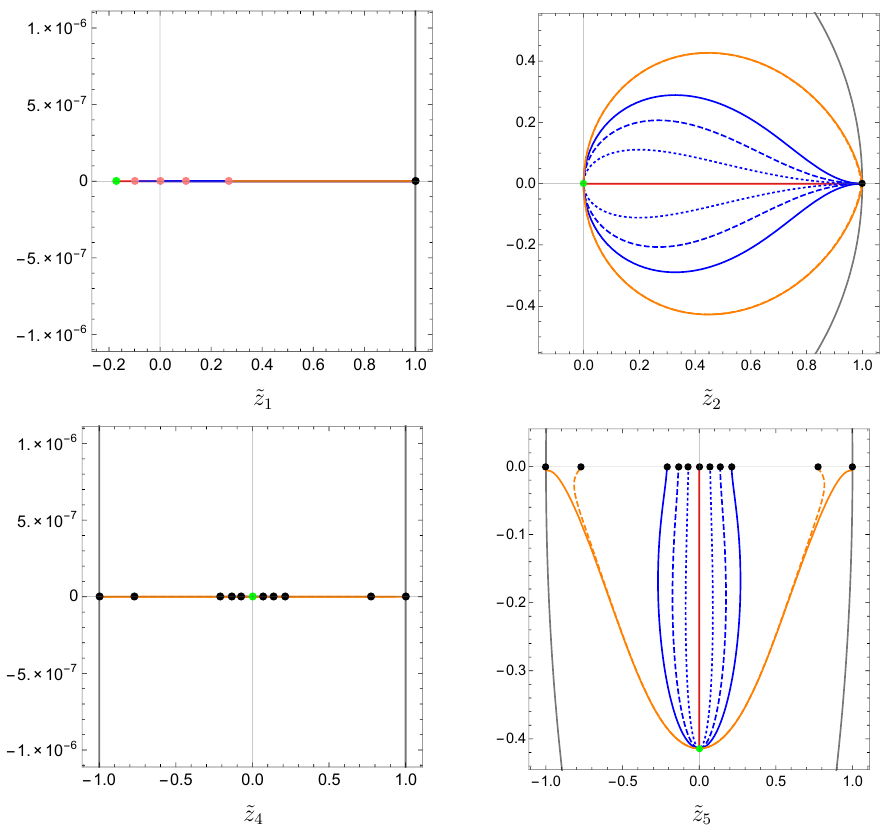
Figure 6 . Samples of regular flows within the SU(2) -invariant sector using the boundary con- ditions (3.31) for the complex scalar fields ˜ z (bottom-right). The N = 2 & U(2) AdS green and black dots, respectively. The grey lines in the left column plots correspond to the boundary values | ˜ z = 1 . The red flow corresponds to the choice (cid:15) ≈ 0 whereas the orange one corresponds 1 | to (cid:15) ≈ (cid:15) . Black dots in the bottom plots are compatible with SO(6) invariance, i.e. ˜ z crit real-valued, and correspond to the values ± Φ at r → ±∞